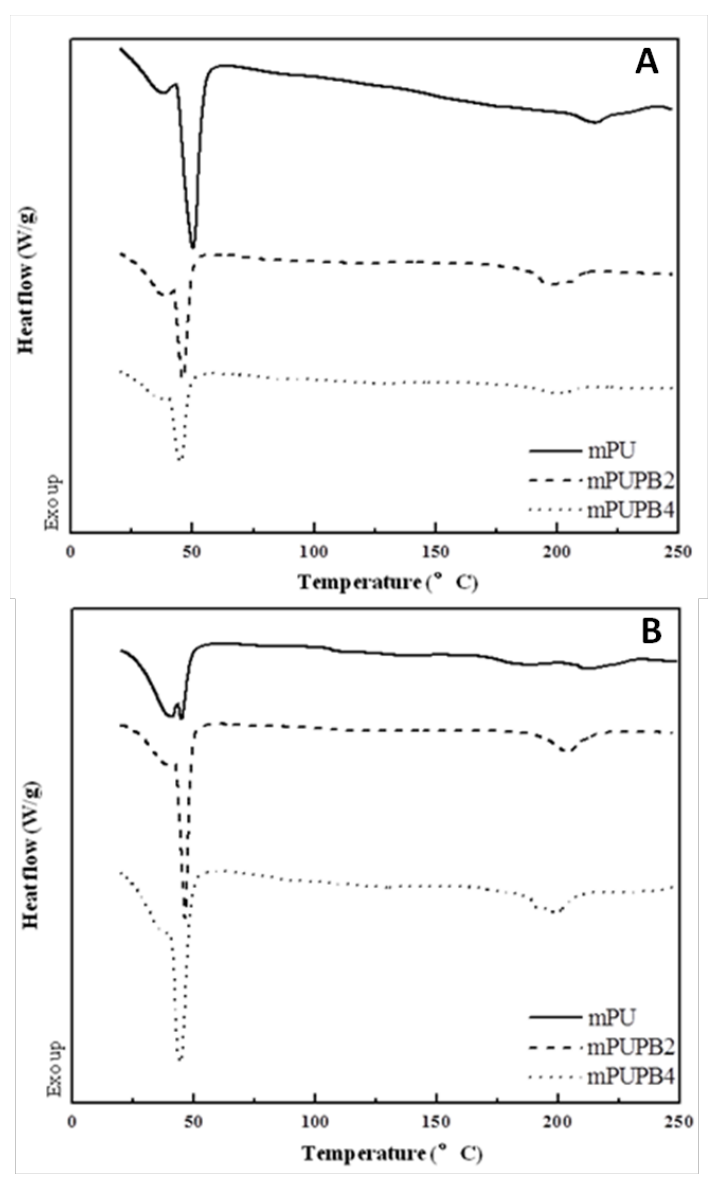
Figure 7. DSC traces of ( A ) unstretched SMPU and its compounds; ( B ) stretched SMPU and its compounds. Scan rate was 10 °C min − 1 . The base SMPU contained crystalline soft-segment.